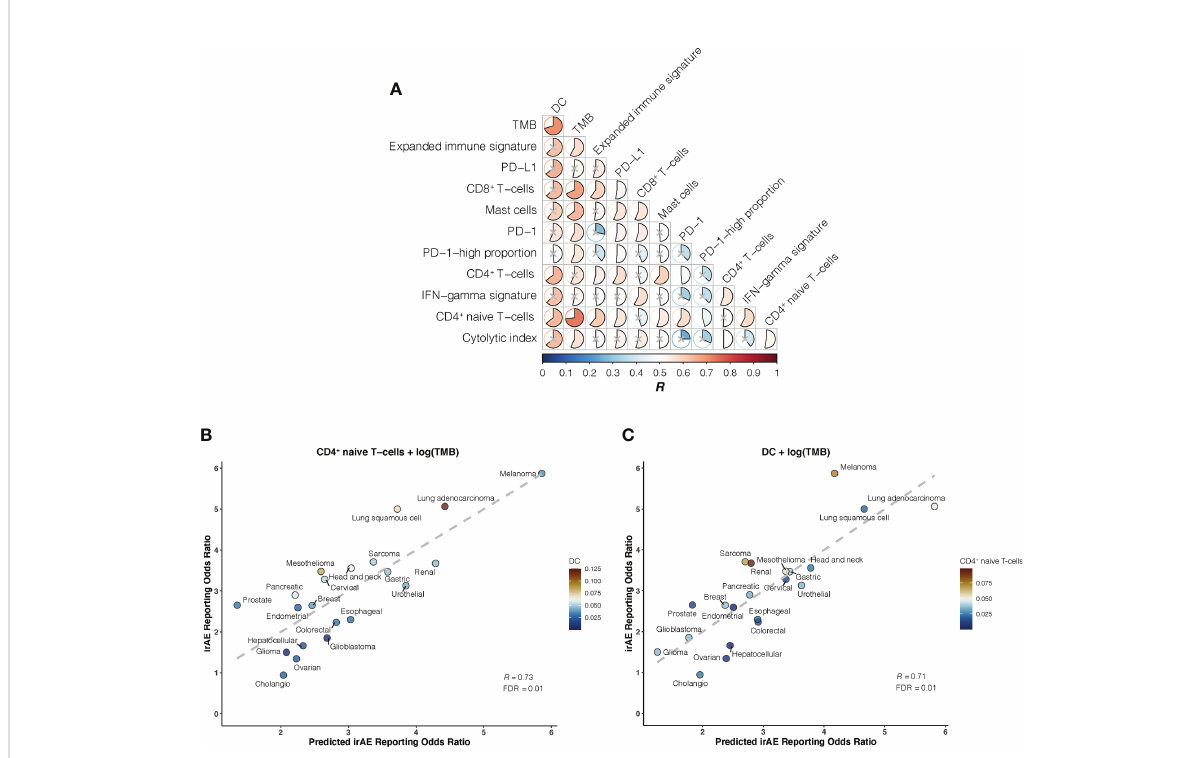
FIGURE 2 Bivariate Models of Candidate Immunogenomic Factors for Predicting Immune-Related Adverse Events for Anti – PD-1 Therapy Across Cancer Types (A) , Graph shows performance ofbivariate models in predictingimmune-related adverse events (irAEs)risk for combinations ofthe 12candidate immunogenomic factors. Pearsoncorrelationcoef fi cient ( R ) is represented in colorsfromdarkblue to dark red asshown in the color bar. Color intensity and the size ofeachpie is proportional to the correlationcoef fi cient. A lack of statistical signi fi canceby log-likelihoodratio test ( P >.05) is indicated with a gray cross. (B) , Combined effectof CD4 + naive T-cells abundance (naiveCD4T) and tumor mutational burden (TMB) bivariate model. The dashed line depicts the linear fi t,with the formula reportingodds ratio (ROR) = 24.41× naiveCD4T + 1.01 × log(TMB) – 2.09.The dendritic cells (DC) abundanceof each cancer type is color coded whereblue indicateslow abundance and red, highabundance. (C) , Combined effectof DCand TMB bivariate model. The dashed line depicts the linear fi t, with the formula ROR = 24.37 × DC + 0.8× log(TMB) – 1.41. The CD4 + naive T-cells abundanceof each cancer type is color coded whereblue indicates low abundance and red,